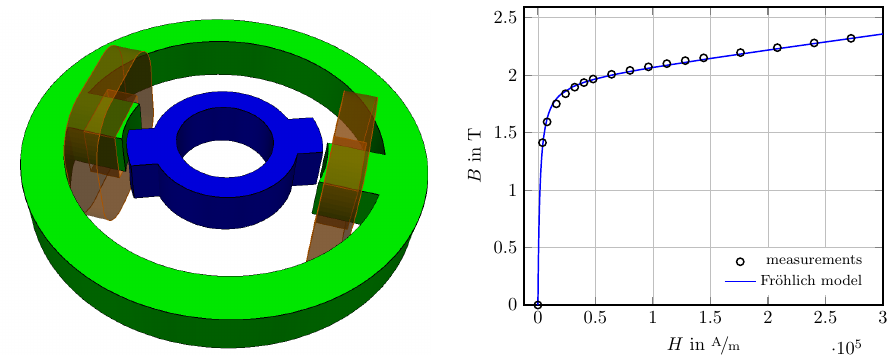
Figure 6. TEAM 24 setup ( left ) with rotor (blue), stator (green), and coils; material behaviour ( right ) with provided data and employed curve representation.